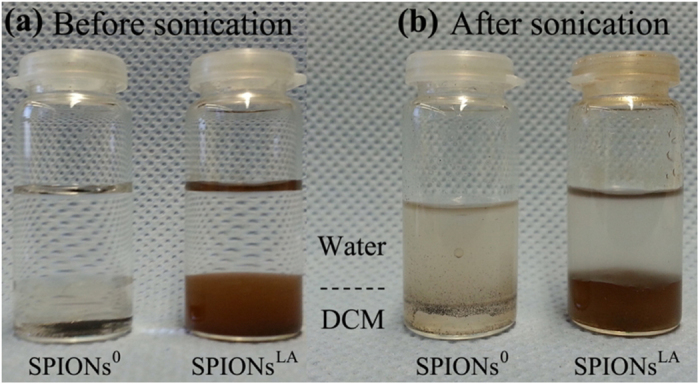
Photos of SPIONs0 and SPIONsLA in water/DCM: (a) just after adding DCM and water, (b) 2 min after sonication.